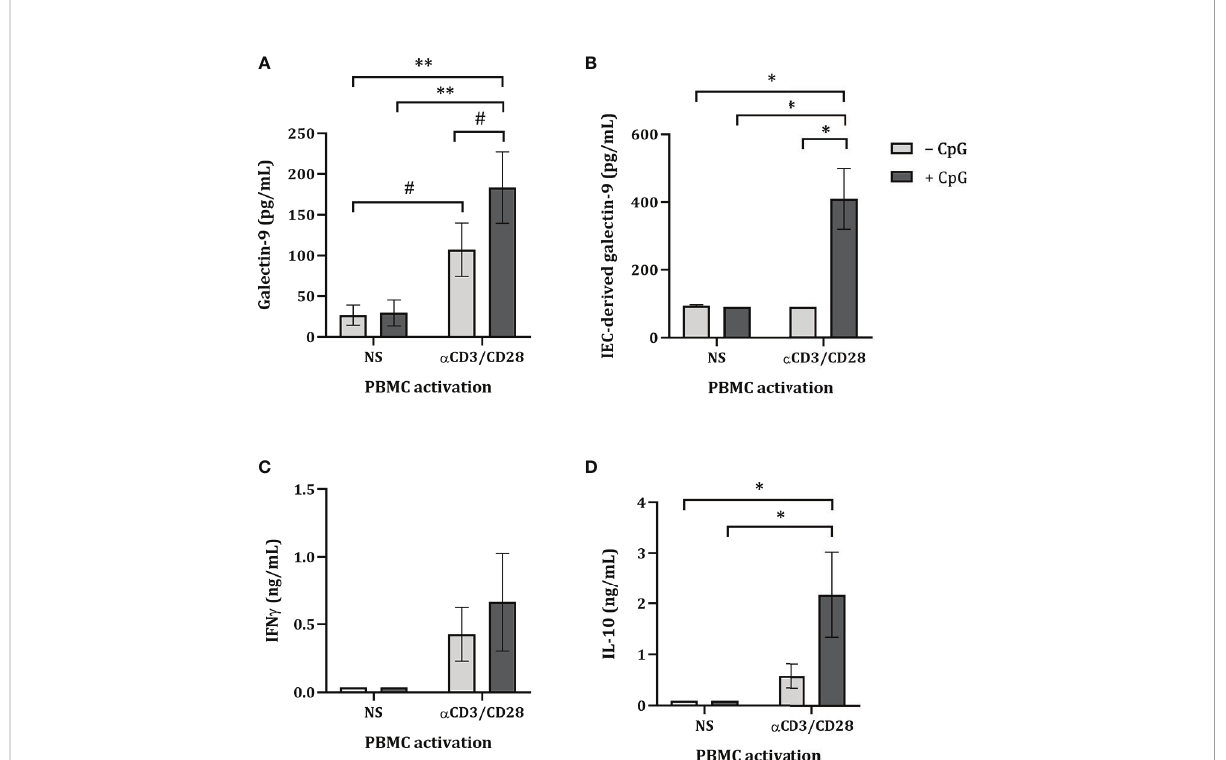
FIGURE 1 Cytokine and galectin-9 secretion in FHs 74 Int/PBMC co-culture model after exposure to non-activated or activated PBMC. FHs 74 Int IEC were stimulated with CpG (0.5 µM) and basolaterally exposed to non-activated (ns) or a CD3/CD28-activated-PBMC for 24 h. After incubation, galectin-9 (A) , IFN g (C) and IL-10 (D) were measured in the basolateral supernatant. Additionally, after IEC/PBMC co-culture, FHs 74 Int were washed and incubated in fresh medium for additional 24 h (total 48h; 24h IEC/PBMC co-culture and additional 24h IEC culture) after which IEC-derived galectin-9 (B) was measured in the basolateral supernatant. Data represent mean ± SEM of n = 3 independent PBMC donors (# p < 0.1, * p < 0.05, ** p <